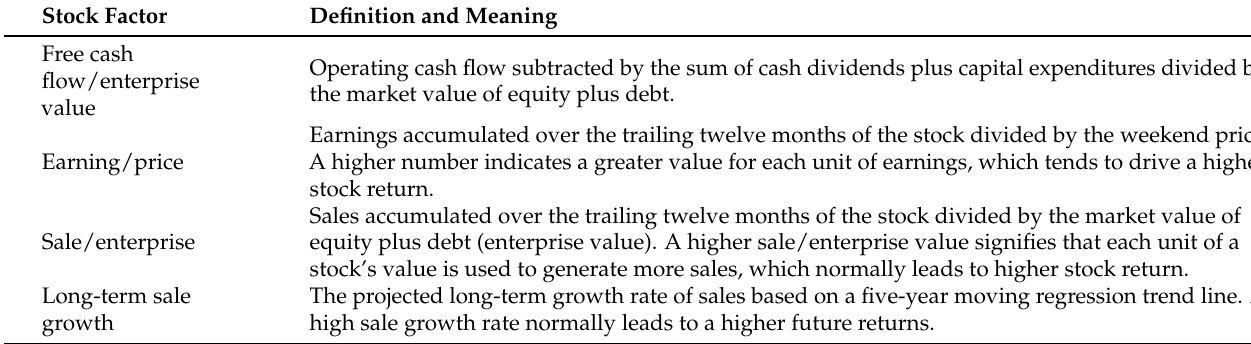
Table 3. Definition of the stock